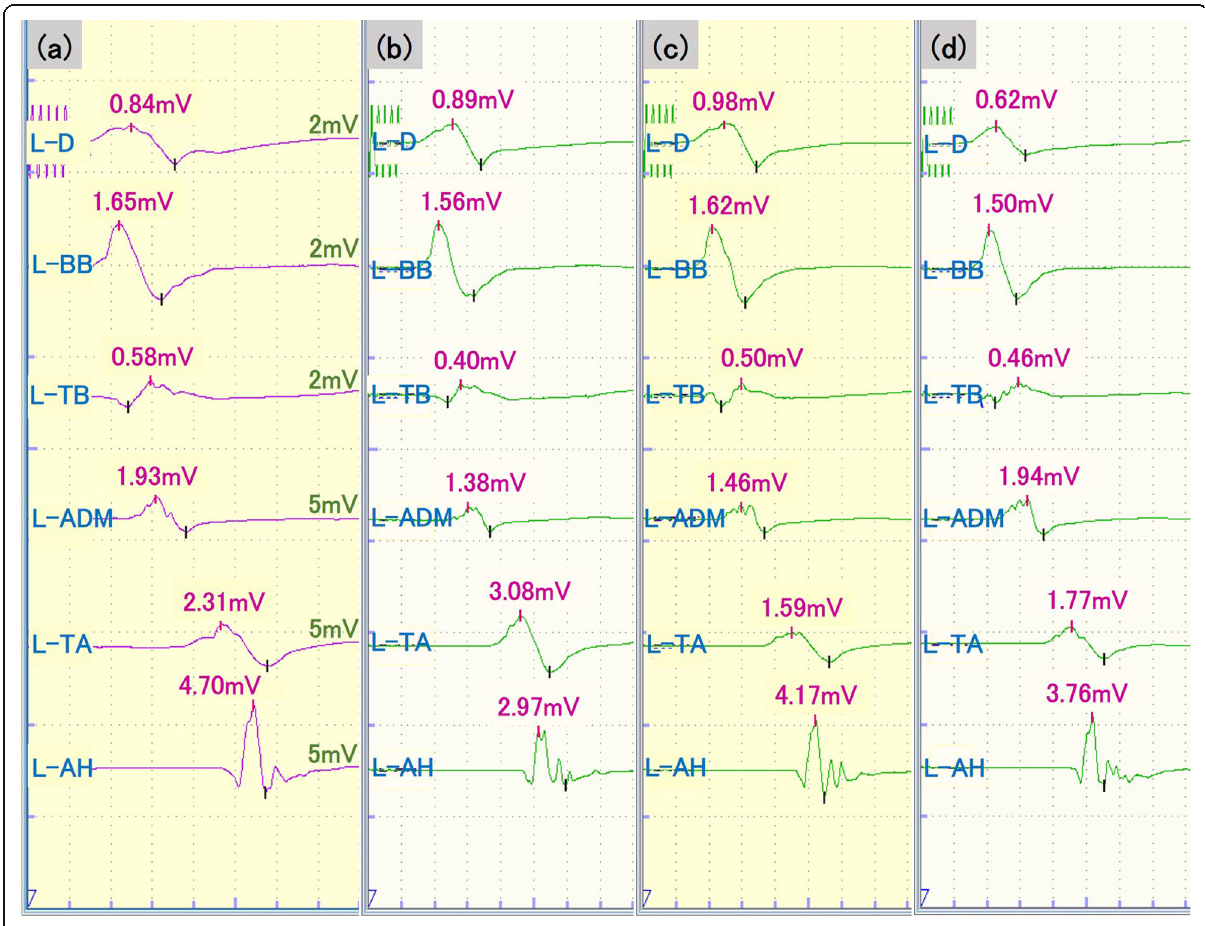
Fig. 2 MEP responses from the left upper extremities before surgery ( a ), during laminoplasty ( b and c ), and at the end of surgery ( d ) in case 2. Remimazolam 0.5 mg/kg/h ( a ), 1 mg/kg/h ( b and d ), or 1.5 mg/kg/h ( c ) was administered with remifentanil 0.3 − 0.5 μ g/kg/min. D, deltoid; BB, biceps brachii; TB, triceps brachii; ADM, abductor digiti minimi, TA, tibialis anterior; AH, abductor hallucis